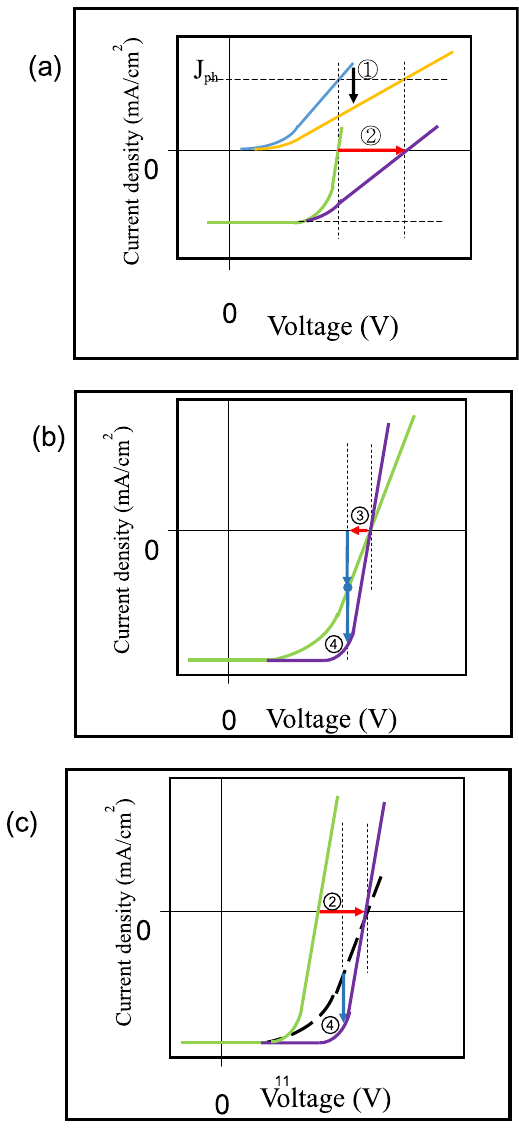
Figure 3. Schematic demonstration of the shape change of J-V curve considering the effects of ClAlPc/C60 PHJ. ( a ) Considering only the effect of suppressing the dark current (label ① ). V oc enhances correspondingly in this case (label ② ). The slope of J-V curve (purple) in front of the V oc point is less than that of J-V curve (green). J ph is the photo-generated current density. ( b ) Considering only the effect of extracting the dissociated charges (label ③ ). The output current enlarges under such a small “external” field (label ④ ). We think that in a voltage range closing to V oc , the effect of a small “external” field on charge extraction is similar to a small bias deviation to the left direction from V oc (marked as a “red arrow”). Supposing under a particular bias, the original output current (blue dot in green curve) is equal to the extracted current by the “external” build-in field (the upper blue arrow), then the final output current enlarges to two times of the original current, because the original current will superimpose on the extracted current (the upper blue arrow moves down). Therefore, the slope of J-V curve (purple) in front of the V oc point is larger than that of J-V curve (green). ( c ) Effects of both improved V oc (label ② ) and enlarged output current (label ④ ). The slope of J-V curve (purple) in front of the V oc point is similar to that of J-V curve (green). Green curve: original type I device. Black dash curve: imaginary J-V curve with only V oc shift. Purple curve: modified type II